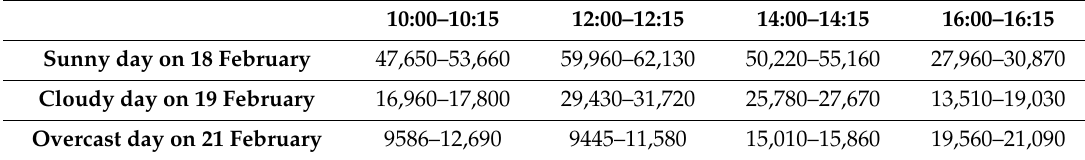
Figure 14. The measured value of C W outdoors at different measurement heights under different weather conditions. Table 1. Illuminance (lux) variation range of ambient light during